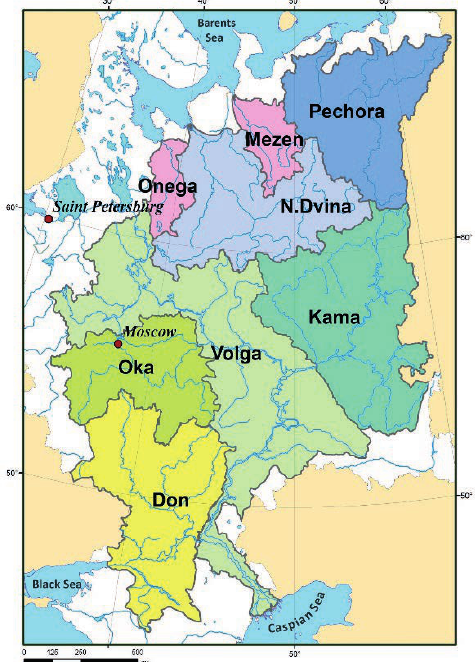
Fig. 3 Studied river basins of European